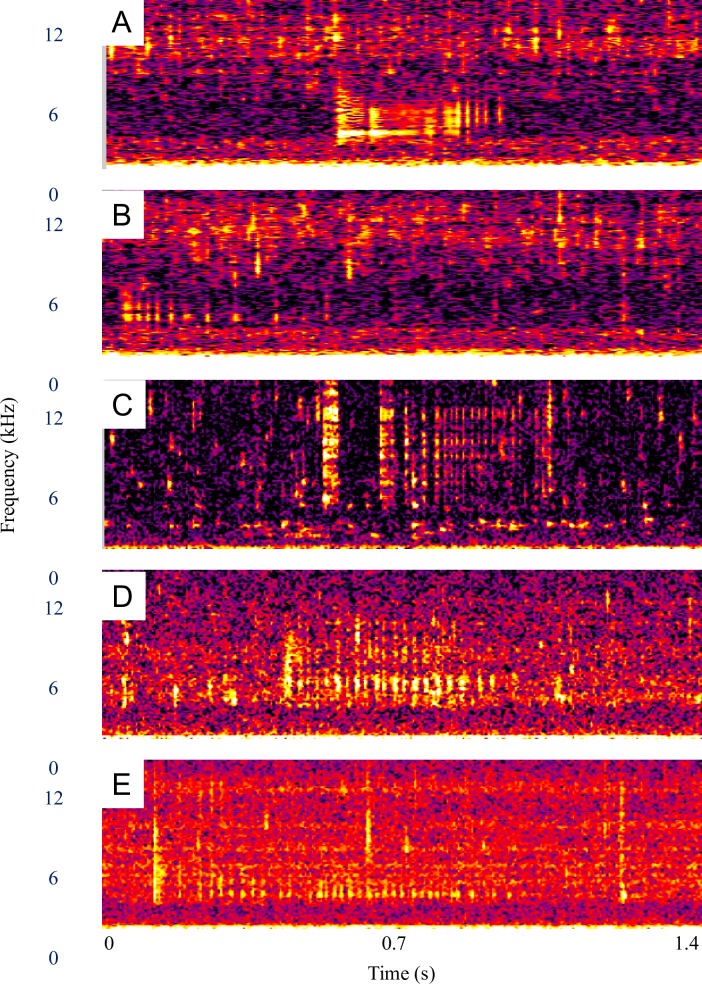
Comparison of “FRT” sounds.(A) and (B) Alewife, (C) brook trout, (D) brown trout, and (E) rainbow trout. Spectrograms in each graph are unfiltered and set to the same parameters (1024 Hann windowed FFTs with 50% overlap), time scale (0 to 1.4 s), and frequency scale (0 to 12 kHz).